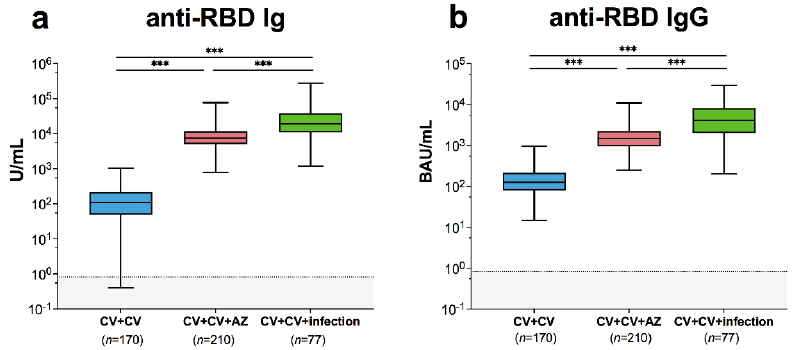
Figure 1. SARS-CoV-2-specific binding antibody responses and neutralizing activities. Immune re- sponse of individuals with SARS-CoV-2 breakthrough infection (CV + CV + Infection) was com- pared to those with fully vaccinated CoronaVac vaccines without infection (CV + CV) and those who received AZD1222 as third booster (CV + CV + AZ). Serum ( a ) anti-RBD Ig activity, ( b ) anti-RBD IgG-binding antibody units. The results are shown as Geometric mean titres with 95% CIs. The cut-off value is indicated as dotted lines. Statistics were calculated using one-way ANOVA with Bonferroni correction. *** p < 0.001.